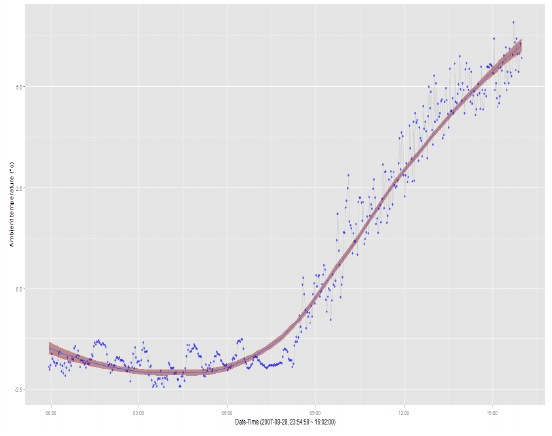
Figure 1 Example of errourness and imprecise data and fluctuations in a real time series data and corresponding data after performing smoothing.